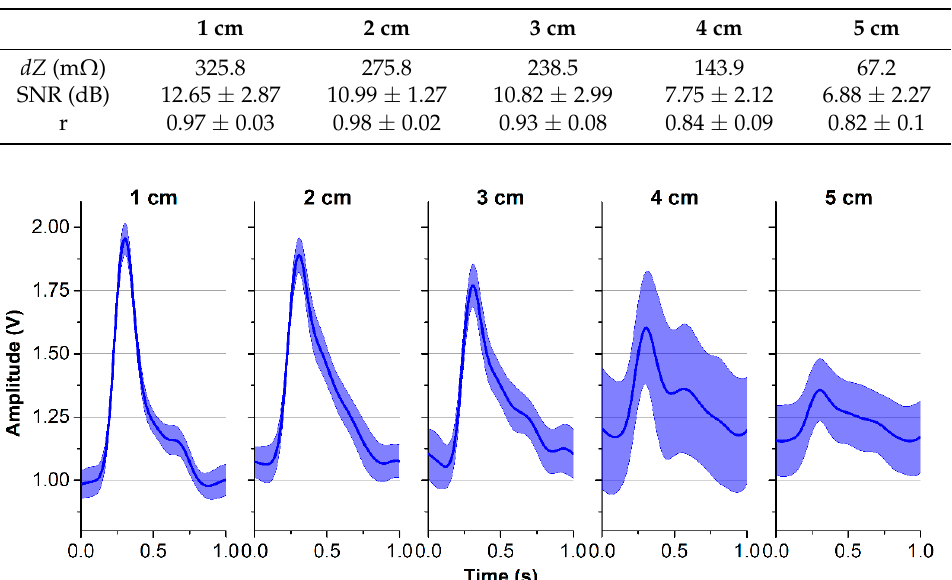
Figure 7. Ensemble average of BI waveforms at various locations.